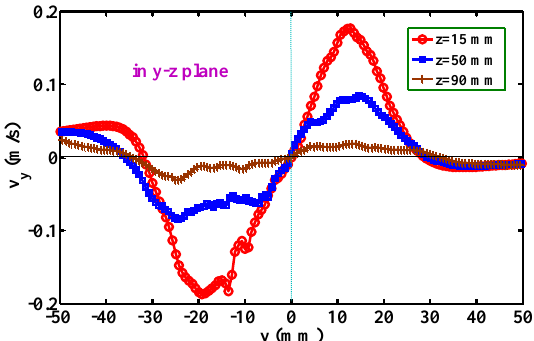
Figure 10. Development of the mean velocity component, v x , for positions below the die face. All positions are in the x-z plane.